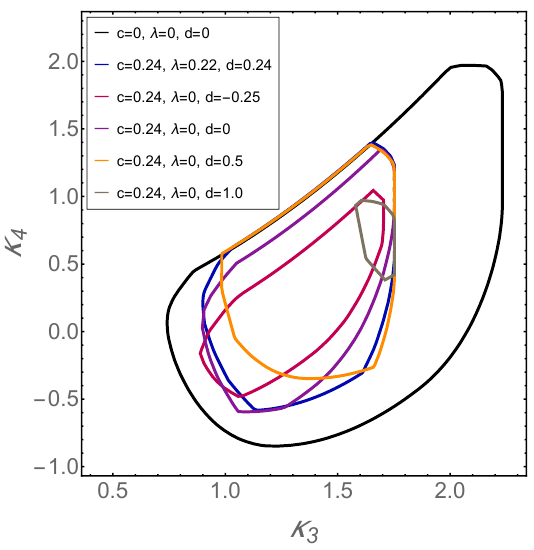
Figure 1 . Positive regions in the ( κ 3 , κ 4 ) -plane for different c , λ and d (the regions within the solid lines are allowed by generalized elastic positivity bounds) in the Z symmetric case. The black line 2 (the largest region) corresponds to the elastic positivity bounds in dRGT gravity. The size of the cross section of this region largely depends on c , while d can dramatically change the shape of this region. At d = d 0 . 5 or d = d 1 . 4 , this region shrinks to a point. min ’ − max ’